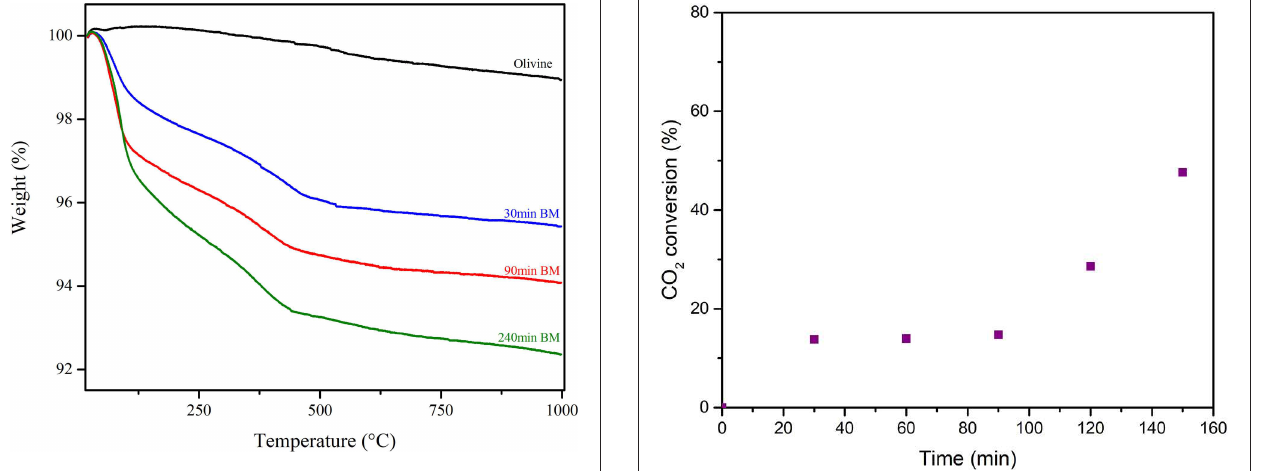
FIGURE 5 | TGA traces carried out over selected samples at the end of the first series runs, i.e., mechanochemical tests carried out under a CO 2 pressure head equal to 1.5 bar.